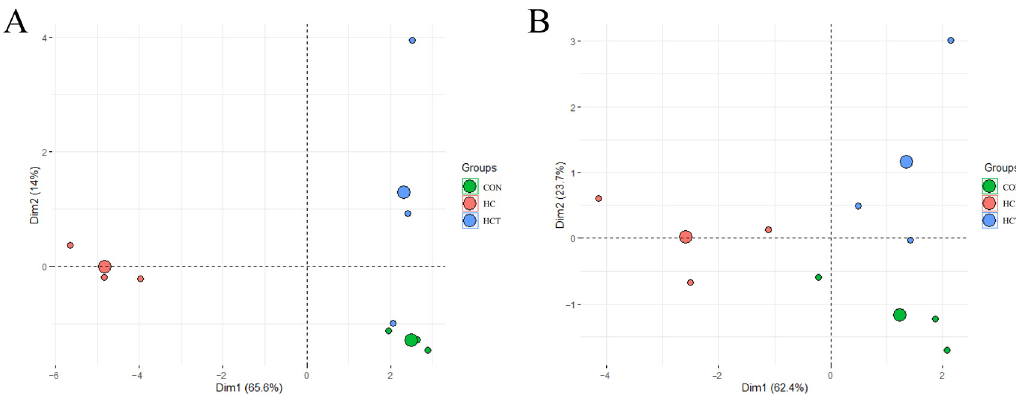
Figure 2. Principal component analysis on the profiles of carbohydrate-related ( A ) microorganisms and ( B ) enzymes in control (CON), high-concentrate diet (HC), and high-concentrate diet supplemented with 200 mg of thiamine/kg of DMI (HCT) treatment.